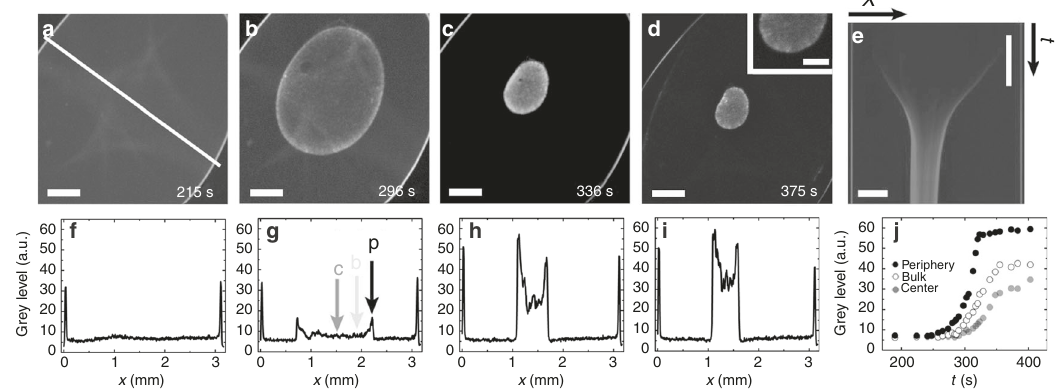
Fig. 5 Density fi elds of buckling contracting sheets. a – d Subsequent epi fl uorescence micrographs of a buckling contracting sheet at low magni fi cation. The buckles appear as straight bright strips at the gel periphery ( d ). Inset ( d ): zoom in at the bottom of the gel showing buckling. Scale bar: 200 μ m. e Kymograph of the density along the line indicated in a . f – i Density pro fi les along the same line corresponding to a – d . j Density as a function of time for the points indicated in g . Actin is labeled with Alexa-Fluor 488. Scale bars: 500 μ m ( a – e ). Time scale bar: 1 min ( e ). Drop volume is 1.1 μ L, chamber height h = 140 μ m, and initial gel radius of short and long axis: R = 1.2 and 2.1